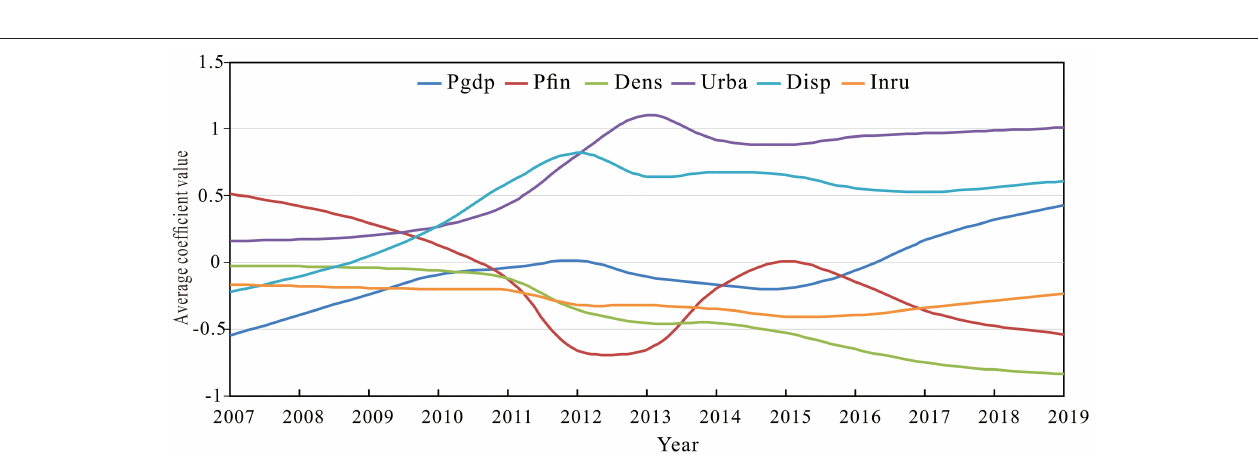
FIGURE 6 | Temporal varying effects of different variables on the supply level of healthcare